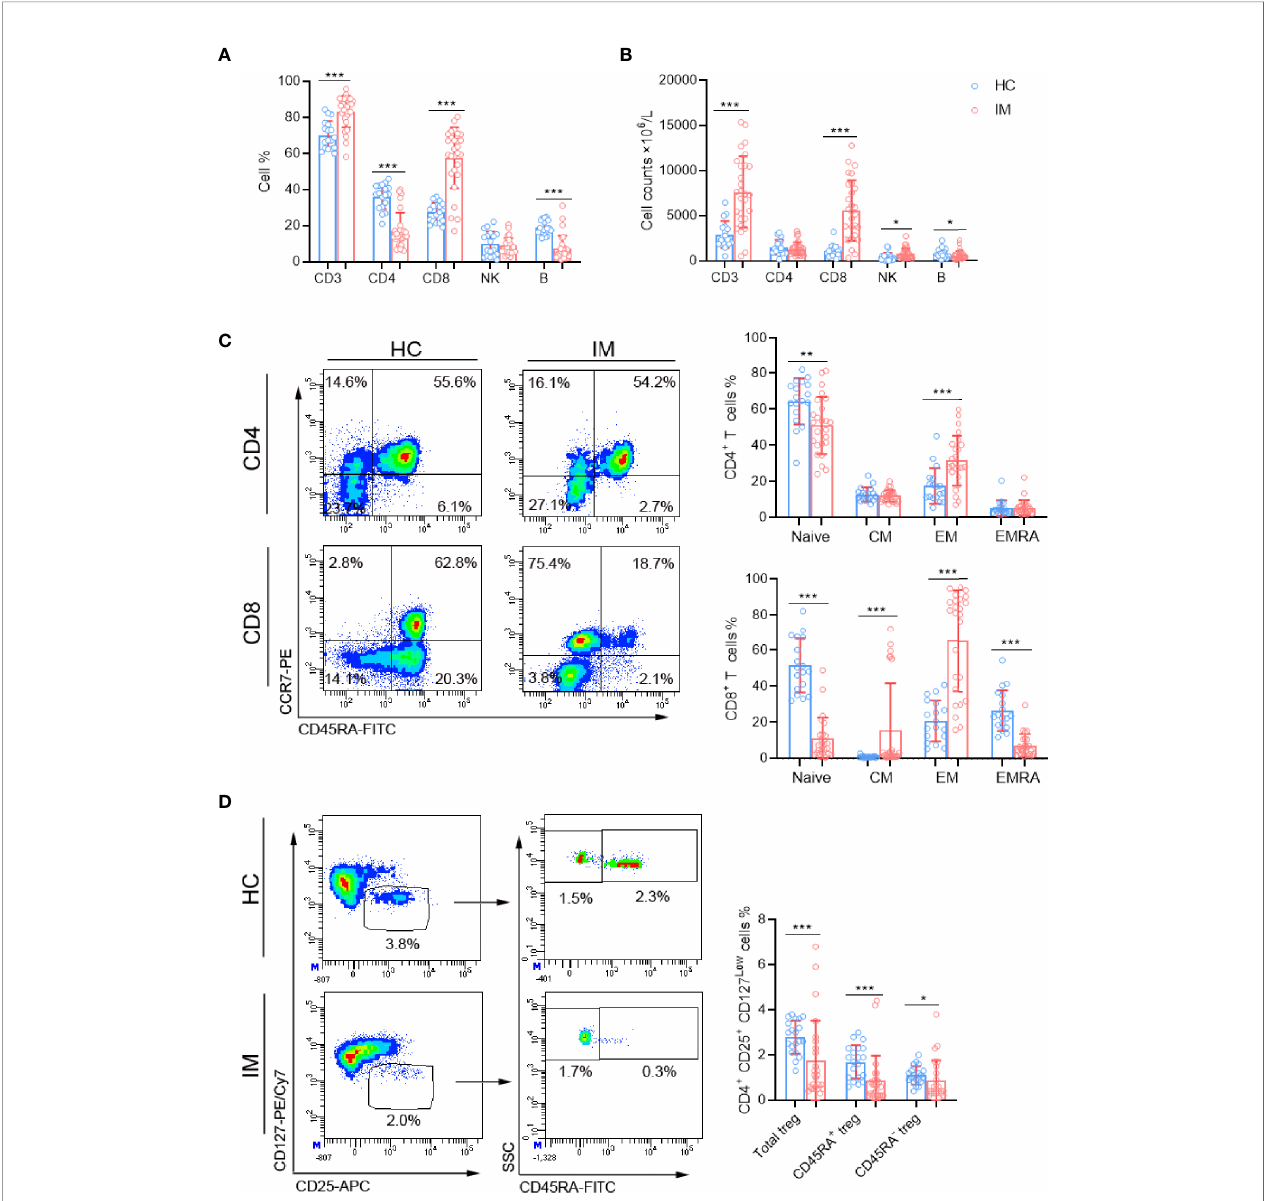
FIGURE 1 | The lymphocyte subsets and immunophenotype characteristics. Circulating lymphocytes in pediatric patients newly diagnosed with infectious mononucleosis (IM) and healthy controls (HCs) were analyzed using fl ow cytometer. (A, B) The percentages and absolute numbers of T cells, B cells, and NK cells in different groups were expressed as mean with standard deviation (SD). (C) A typical example of the gating strategy is shown. CD4 + and CD8 + Naïve (T Naïve , CCR7 + CD45RA + ), central memory (T CM , CCR7 + CD45RA − ), effector memory (T CM CCR7 − CD45RA − ), and EMRA (T EMRA , CCR7 − CD45RA + ) T cell subsets were shown. The percentages of CD4 + T and CD8 + T cell subtypes in different groups were expressed as mean with SD. (D) Representative fl ow dot plots showing the gating of Tregs (CD4 + CD25 + CD127 low ), CD45RA + Tregs and CD45RA − Tregs. The percentages of Tregs, CD45RA + Tregs, and CD45RA − Tregs in lymphocytes were expressed as mean with SD. Blue circle points represent HCs, and red circle points represent IM patients. * p < 0.05, ** p < 0.01, *** p <